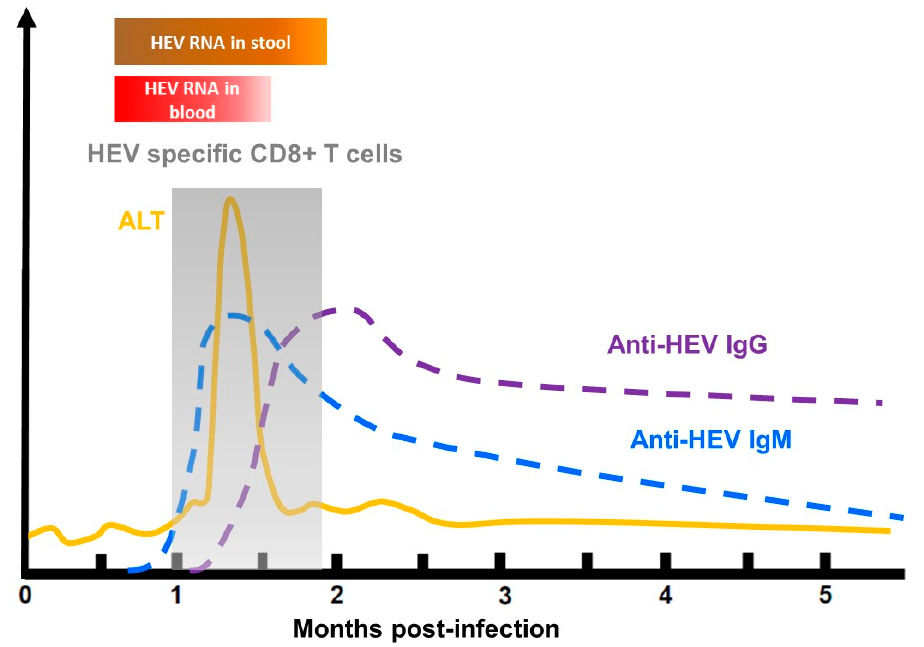
Figure 4. Course of an acute HEV infection. ALT: alanine aminotransferase activity.